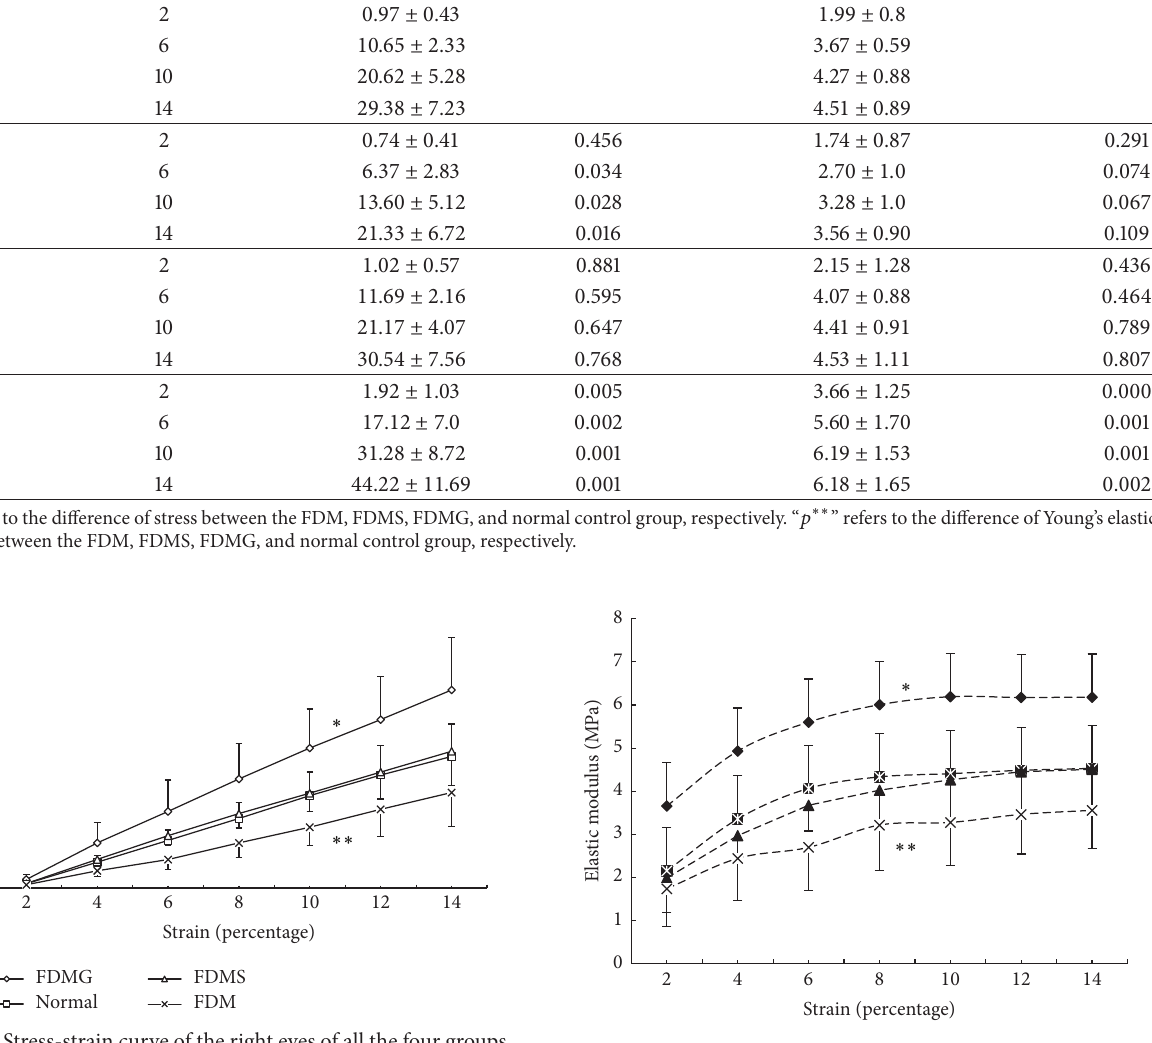
Figure 3: Stress-strain curve of the right eyes of all the four groups. A single asterisk indicates that the stress in the FDMG group was significantly higher than in the other groups ( 𝑝 < 0.05 ). A double asterisk indicates that the stress in the FDM group was lower than in the normal control group, when the strain was ≥ 6%; the difference was significant ( 𝑝 < 0.05 ). The stress in the FDMS group was similar to that in the normal control group.